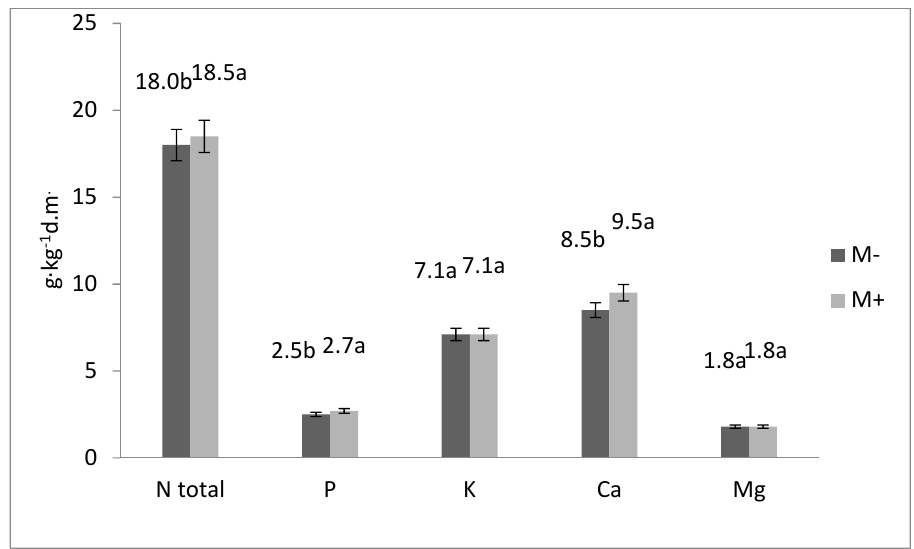
Figure 2. Influence of mycorrhization on concentration N-total, P, K, Ca and Mg (g·kg − 1 d.m.) in leaves of azalea cv. ‘Anneke’. Mean from years. Without ERM (M-) = nonmycorrhizal plants; with ERM (M+) = mycorrhizal plants. Results marked with the same letters are not significantly differ- ent.